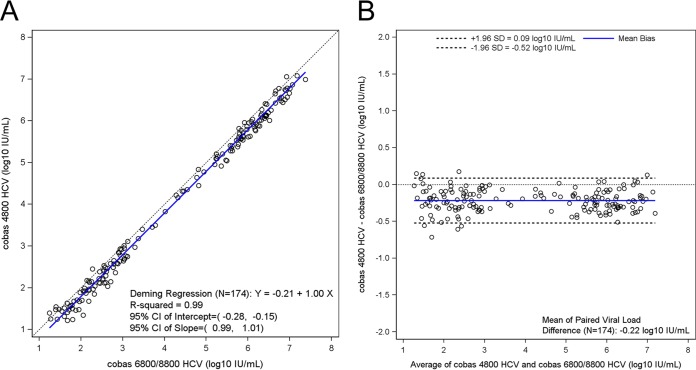
(a) Deming regression plot for cobas 6800/8800 HCV versus cobas 4800 HCV (n = 174). (b) Bland-Altman plot for cobas 6800/8800 HCV versus cobas 4800 HCV (n = 174).